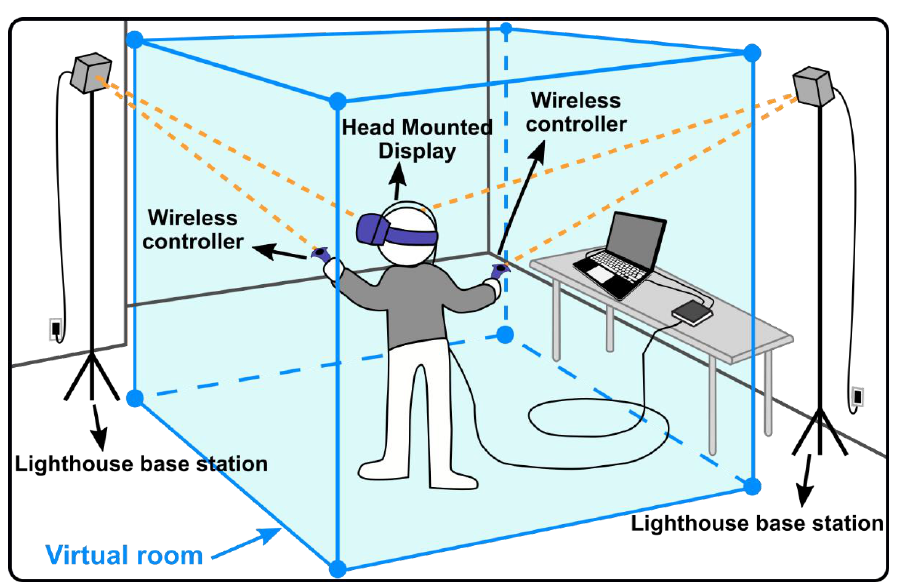
7 of 17 Figure 3. Script PlayerController.cs and list of written programming scripts for running the game . 3.3. Participants and Experimental Process We invited 40 game users, selected at random among students, who declared to spend over 10 h per week on screen games but lacking any experience with VR games, to participate in the research. Twenty game users collected coins by means of teleportation, and the other half by walking around the holm. Game users, aged 17-26, participated in the game voluntarily, without any financial gratification, and could resign from further gameplay at any moment. The research was conducted on a laptop with Windows 10 and two applications cre-